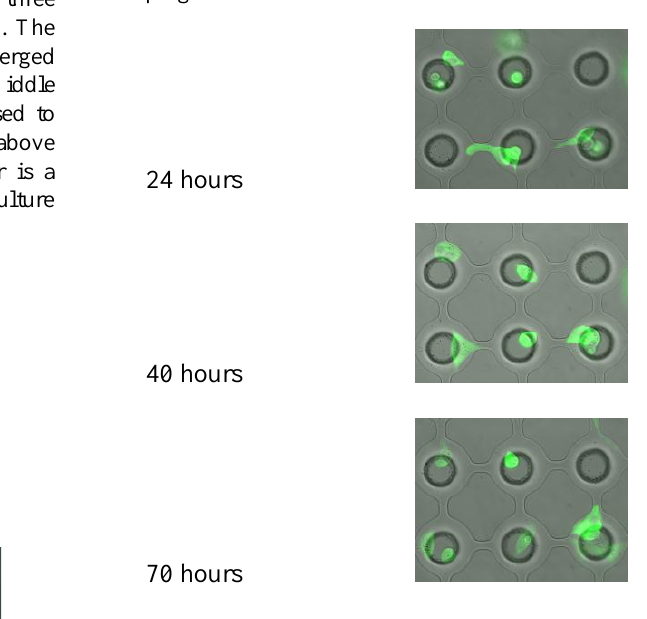
Figure 2. MCF7 cell behavior in microhole device after 24, 40 and 70